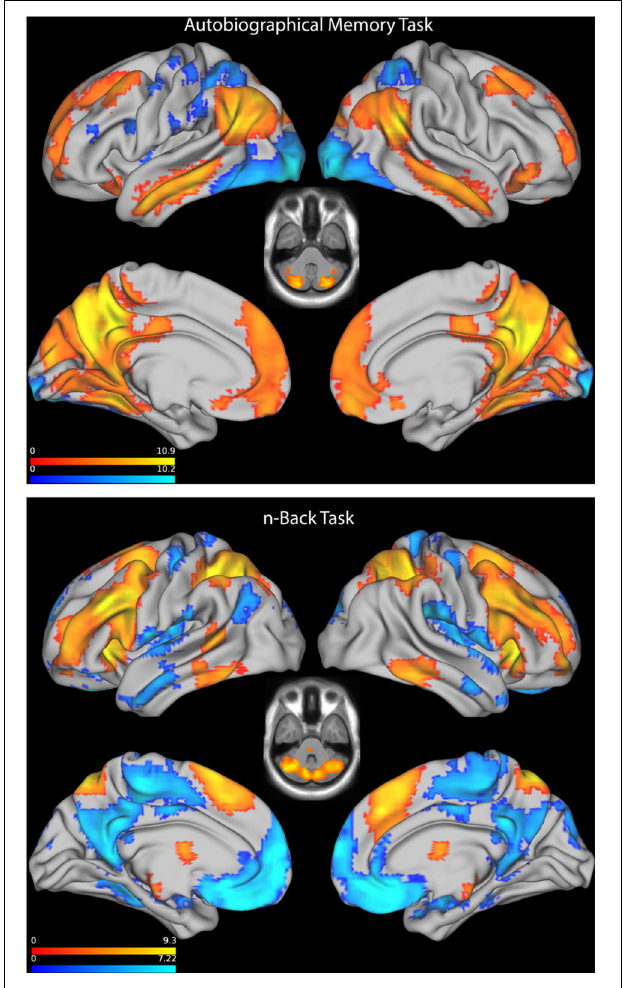
FIGURE 2 | Top: Statistical parametric map showing activation, combined across controls, and OSA patients, on the Autobiographical Memory Task. Axial plane through cerebellum shown at z = − 39. Bottom: Statistical parametric map showing activation, combined across controls and OSA patients, on the n-Back Task. Axial plane through cerebellum shown at z = − 34.5. SPMs are feature thresholded at p < 0.001, followed by family wise cluster thresholding at p < 0.05.